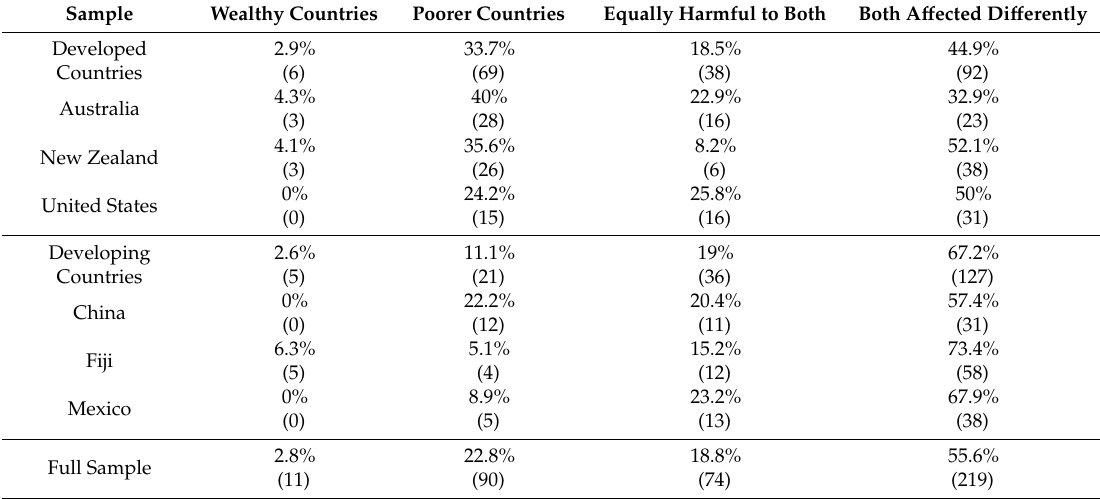
Table 8. Frequency on item: climate change will be more harmful in which country groups.